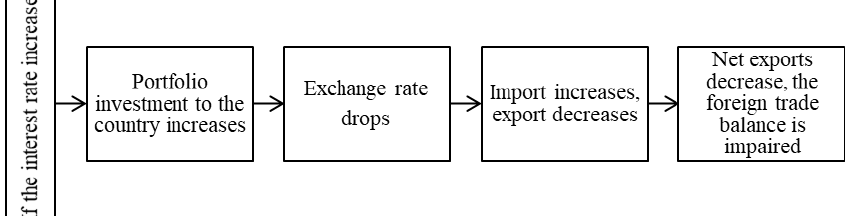
Figure 3. Effects of increase of interest on exchange rate and foreign